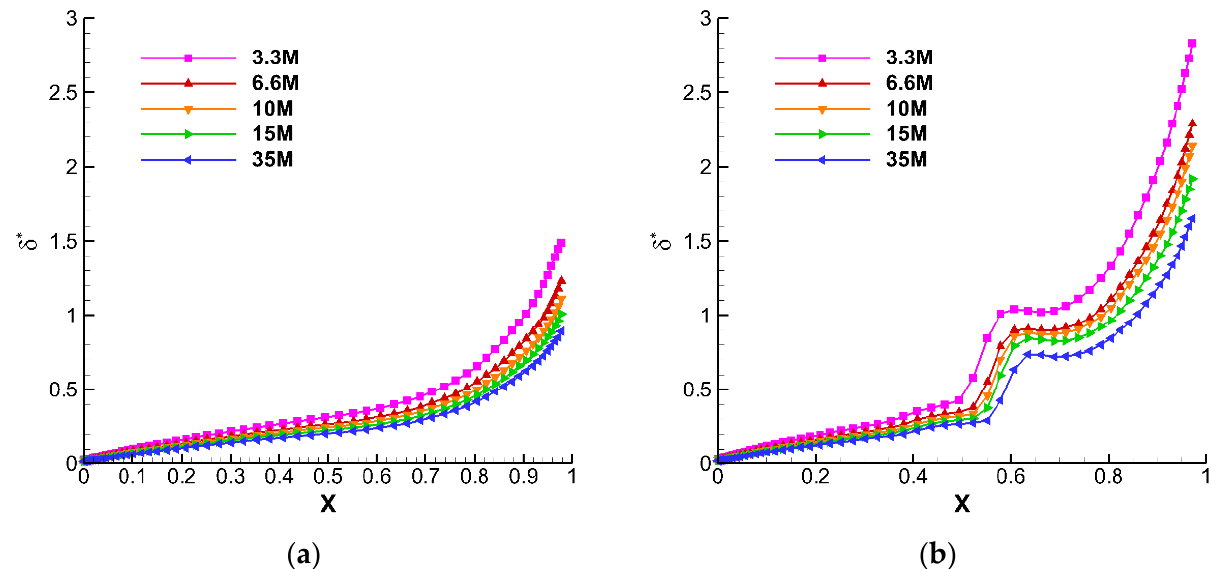
Figure 17. Numerical boundary layer displacement thicknesses of the upper wing surface at different Reynolds numbers (M = 0.76, η = 0.35): ( a ) α = 0°; ( b ) α = 4° .